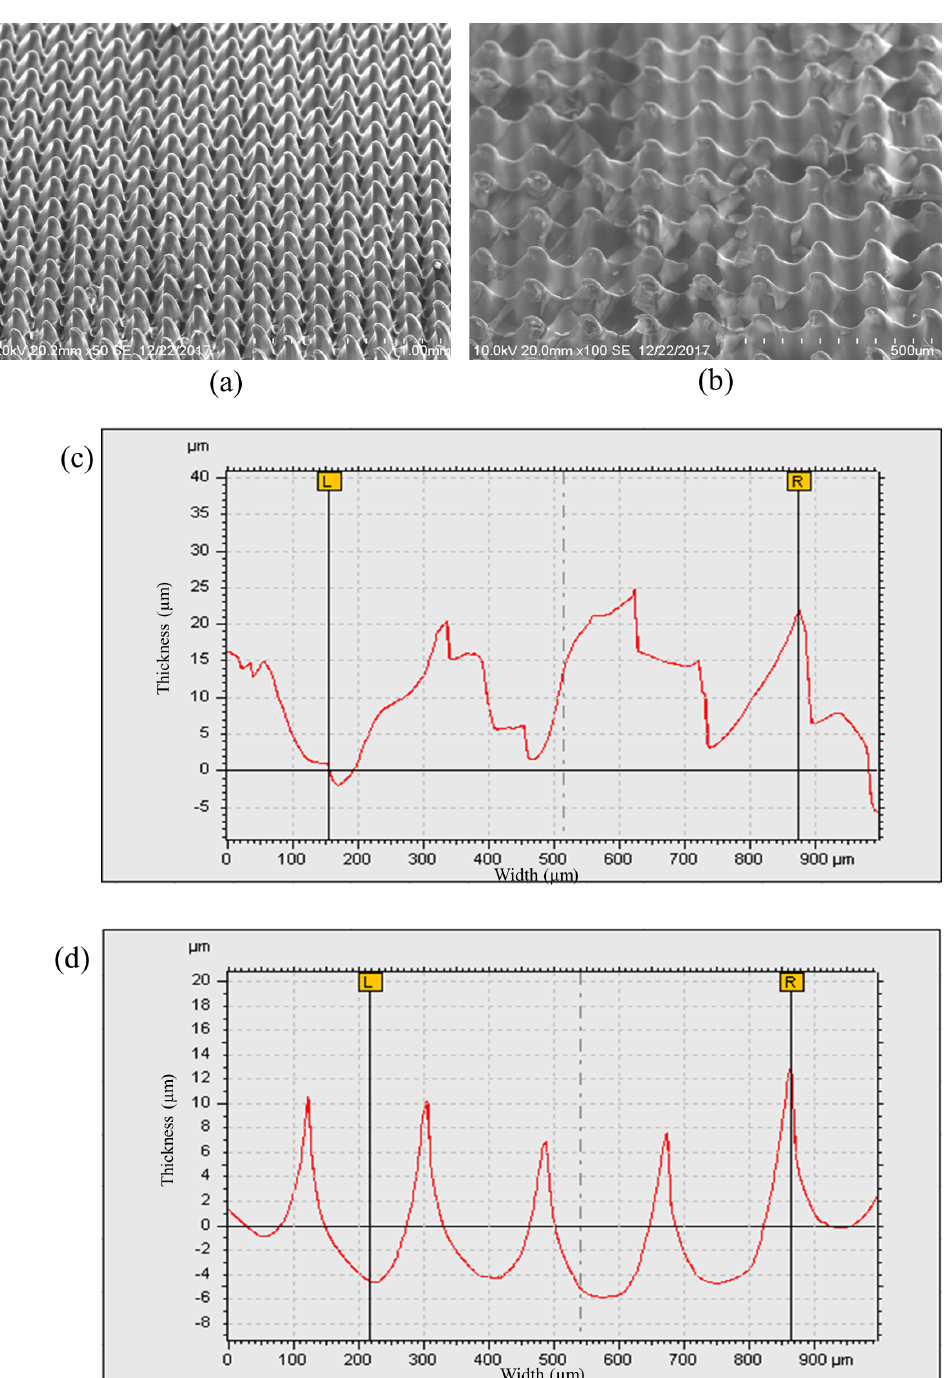
Figure 10. Micropillars with 80 µ m width: ( a ) SU8-10 micropillar master mold, ( b ) replicated PDMS micropillar, ( c ) surface profile of the SU8-10 micropillar master mold, and ( d ) surface profile of the replicated PDMS